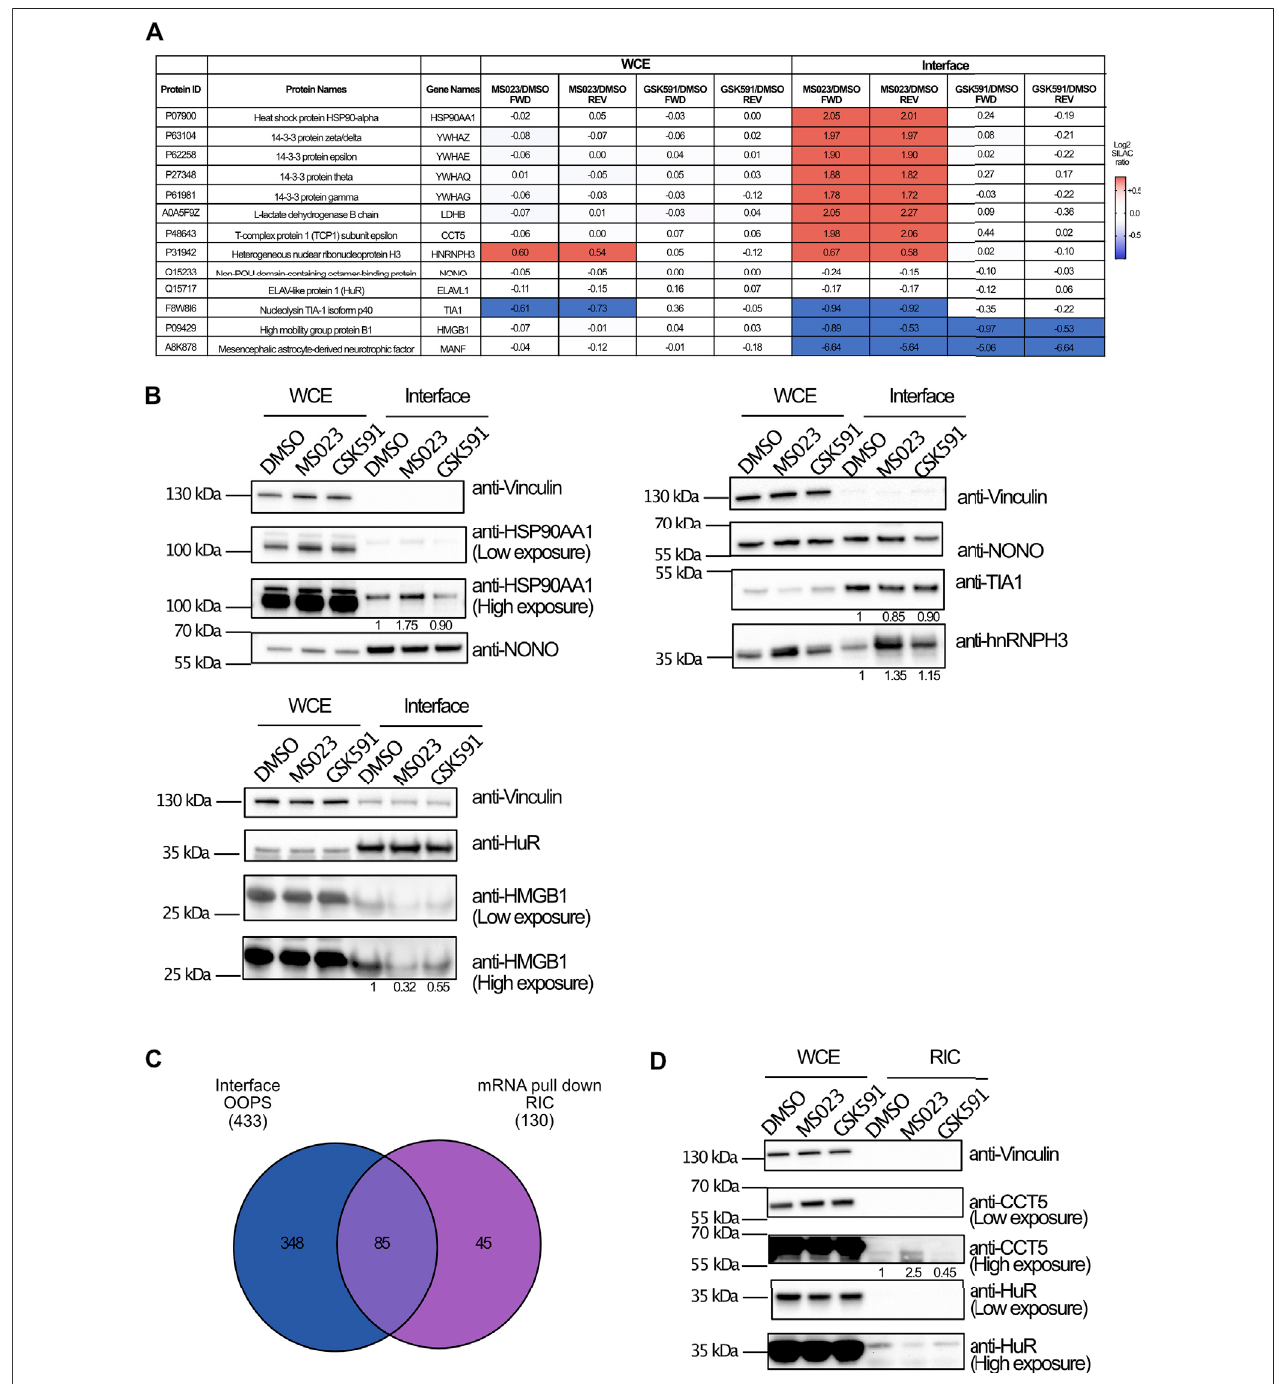
FIGURE4| WB validationoftheMS-proteomicsdata. (A) Overview ofrepresentativeRBPsquanti fi edbySILACOOPS.TablesummarizestheMS023/DMSOand GSK591/DMSO SILAC protein ratio of representative proteins, both in the WCE and in the interface fraction, both in FWD and REV experiment. (B) WB validation of the differentialproteinresponsetoPRMTinhibitorsuponOOPS.WBpro fi lingofrepresentativeproteins,whoseMS023/DMSOSILACproteinratioissummarizedin (A) ,was used to assess the different modulation upon drugs treatment in both WCE and interface fraction: HSP90AA1 and HMGB1 were selected as examples of proteins up-regulated and down-regulated, respectively, in the interface fraction but not in WCE upon MS023; hnRNPH3 was selected as example of protein up-regulated upon MS023 in the interface as consequence of a similar modulation in the WCE; TIA1 was selected as example of protein down-regulated upon MS023 treatment as consequence of a similar modulation in the WCE; NONO and HuR, displaying SILAC protein ratios around 1 in the interface, were selected as loading controls for the interface fraction. Protein abundance in the interface upon different treatments were evaluated upon multiple normalization of band intensities, as described in